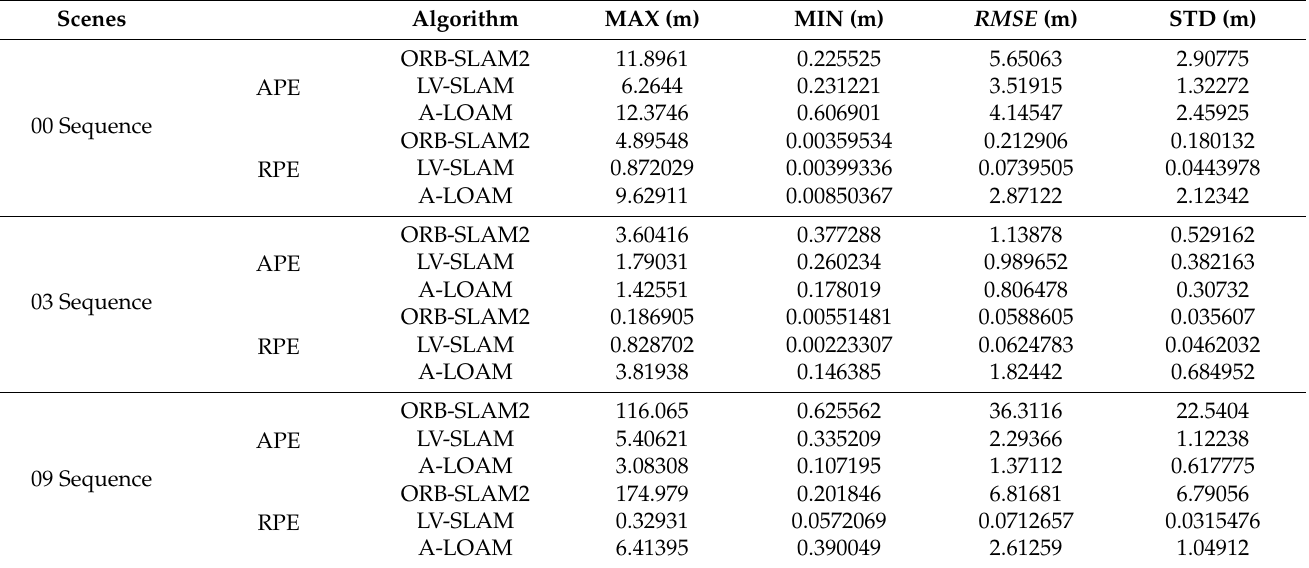
Table 1. KITTI sequence error